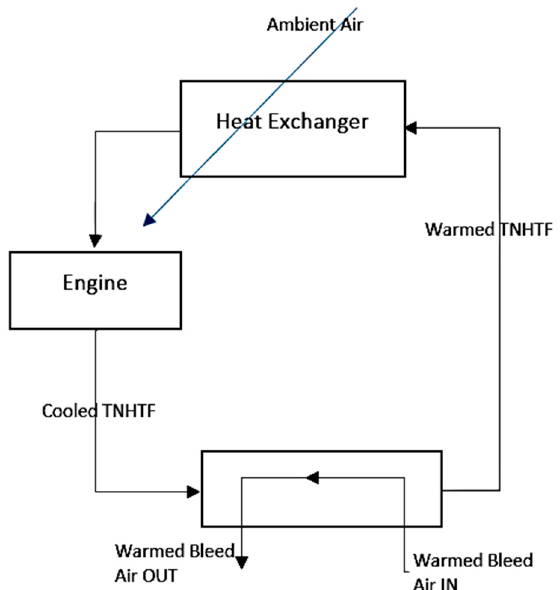
Figure 9. Thermal management system embodiments with thermally neutral heat transfer fluid for cooling the compressor bleed air.